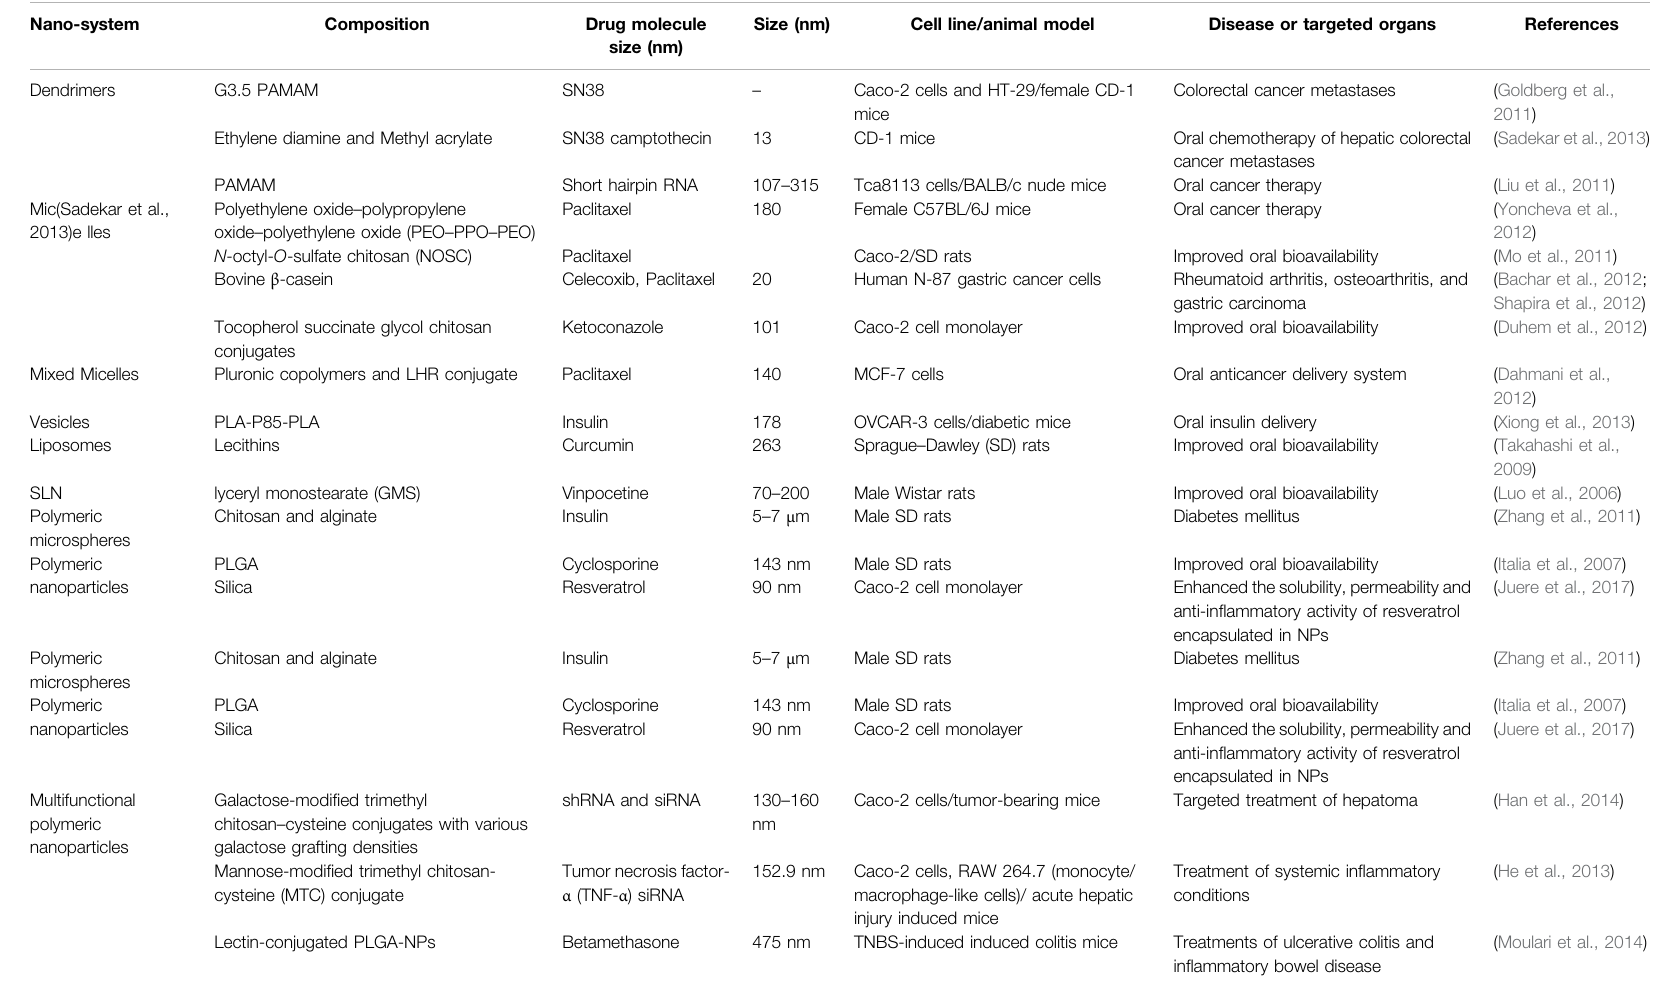
TABLE 9 | List of nanocarrier applications in oral drug